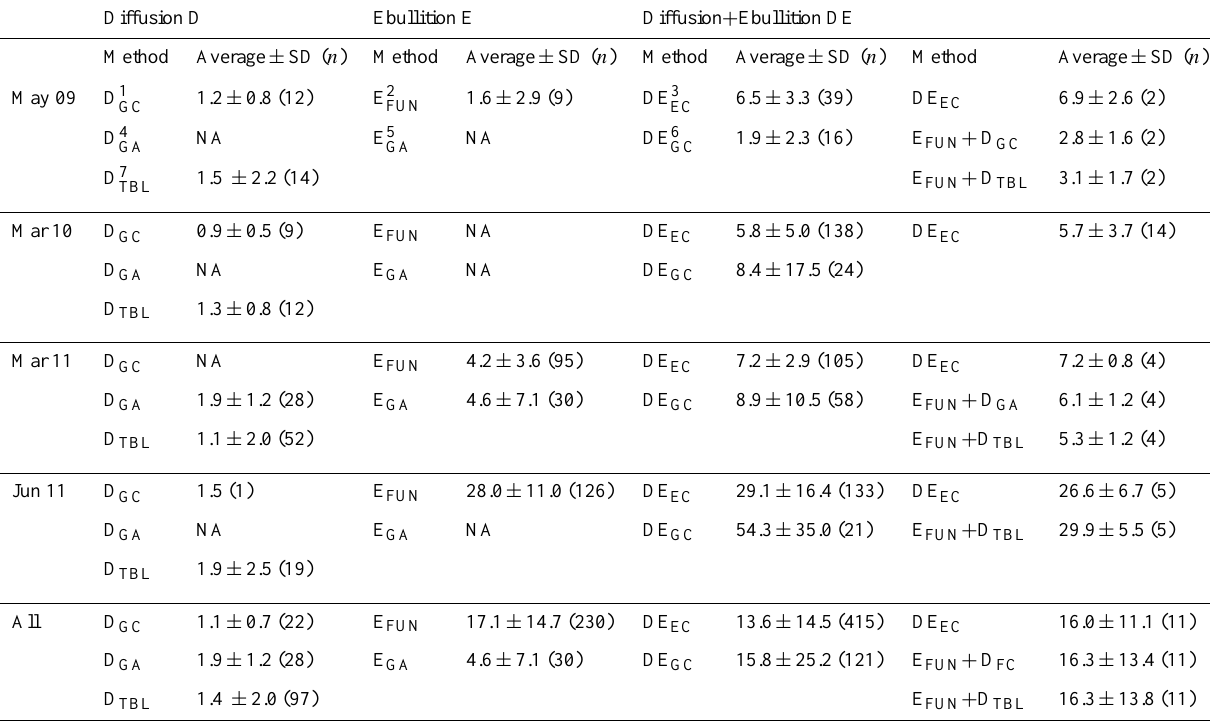
Table 1. Comparison of different methods to assess CH 4 emissions. All fluxes are in mmolm − 2 d − 1 (average ± standard deviation), and the number of measurements ( n ) is given between brackets.